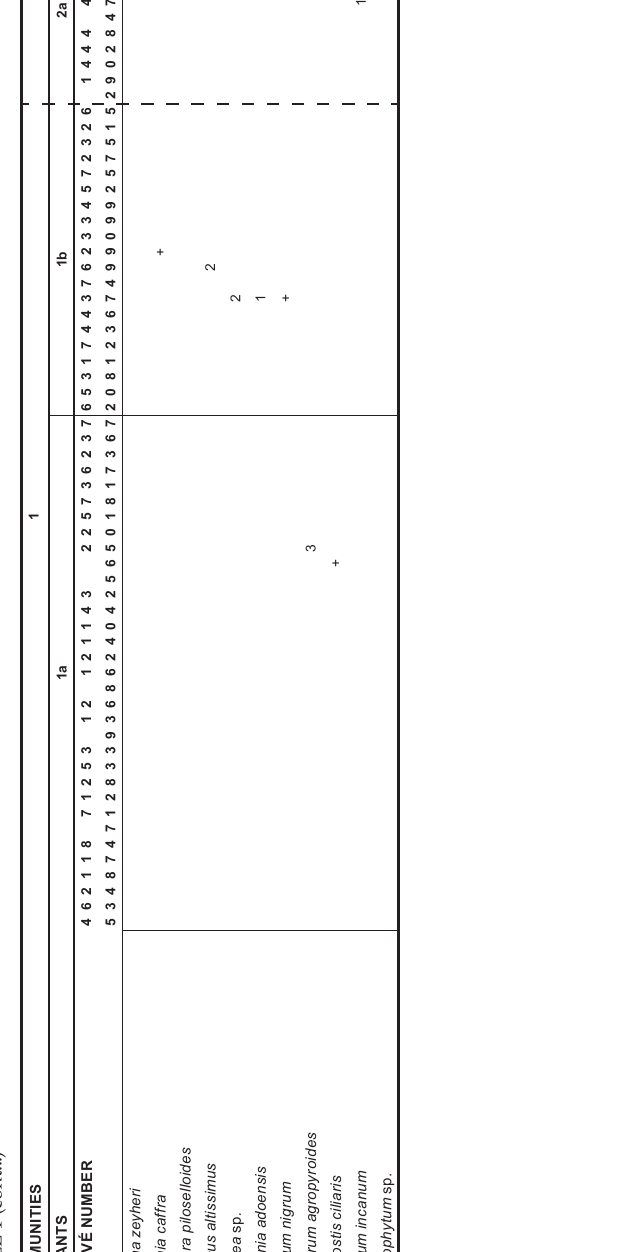
Figure 2 Histogram indicating the percentage canopy cover for the growth forms recorded in the main plant communities and their associated variants in the Andover Game